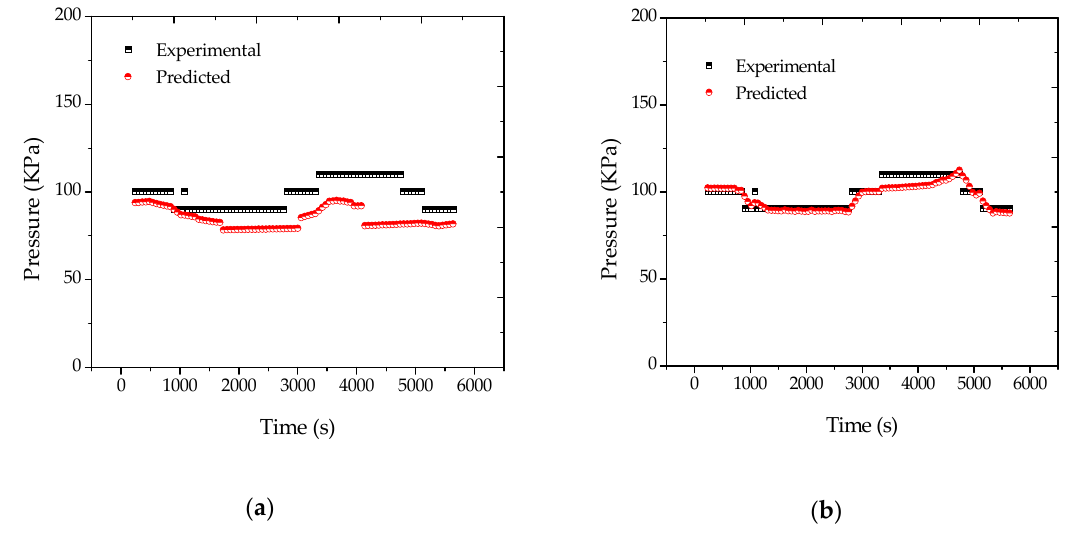
Figure 4. ( a ) Reconciled pressure profiles for reaction R1, considering ( a ) the traditional equilibrium approach and ( b ) the existence of fresh monomer droplets.